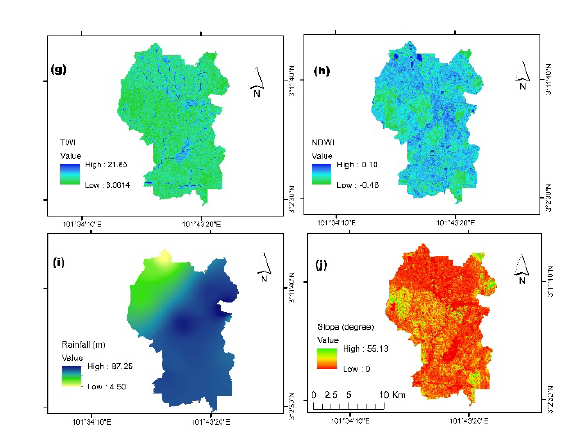
Figure 3: Flood criteria (g) TWI (h) NDWI (i) Rainfall (j)